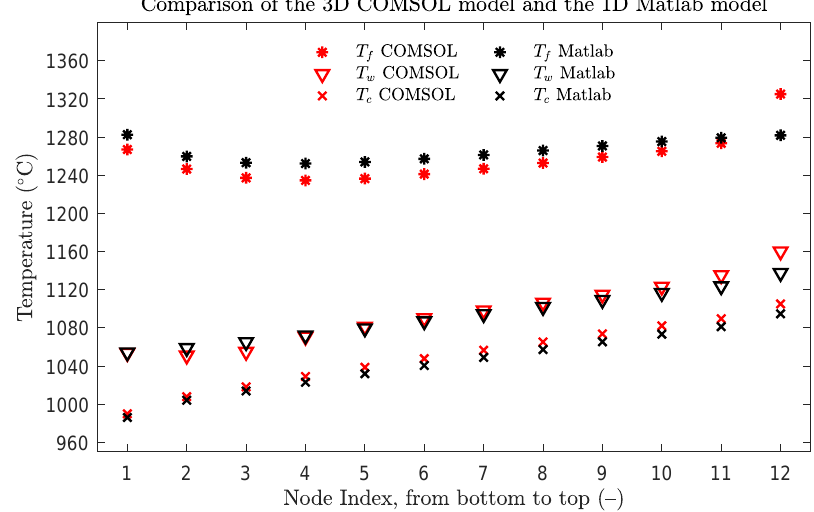
Figure 7. Verification of the 1D Matlab model against the 3D COMSOL